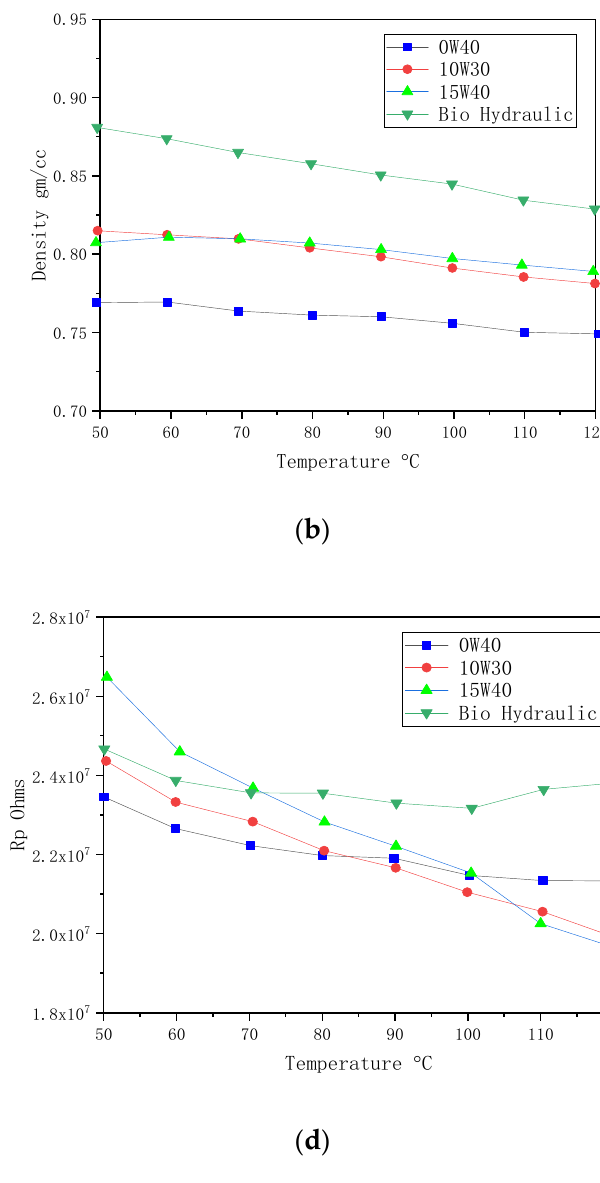
Figure 20. Measurements of 0W40, 10W30, 15W40 oils and biohydraulic oil: ( a ) viscosity; ( b ) density; ( c ) dielectric; and ( d ) Rp. ( d )